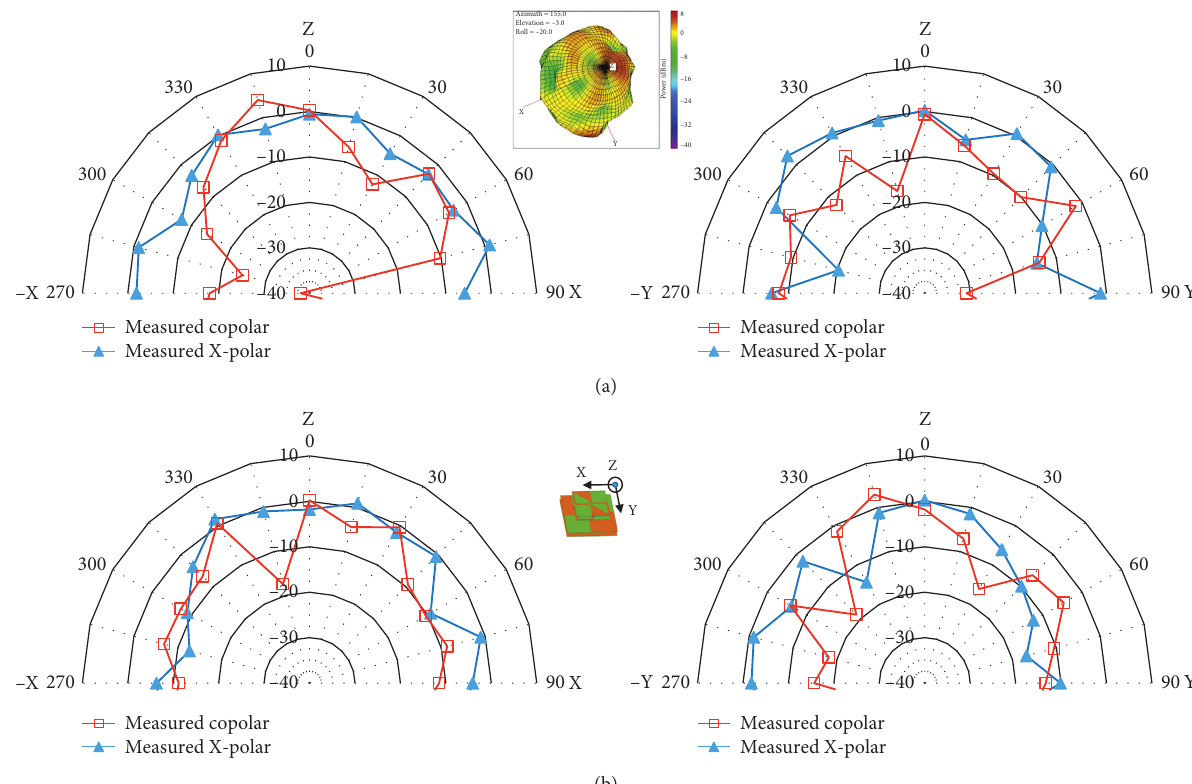
Figure 12: Measured radiation patterns when feeding on xz-plane and yz-plane at 5.8GHz: (a) port-1 and (b)